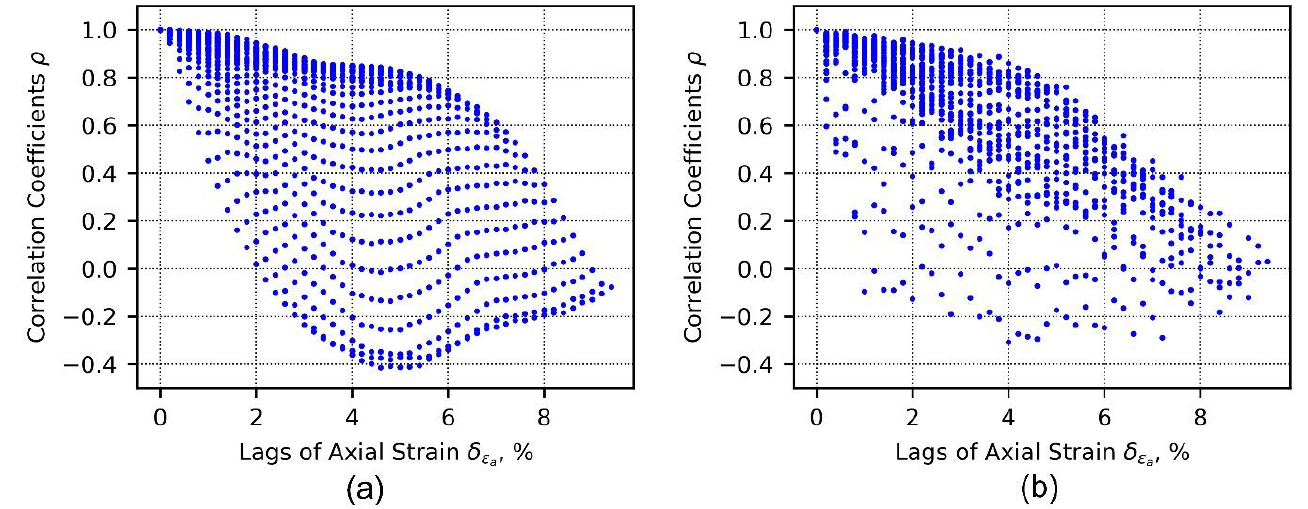
Figure 5. Correlation coefficients computed from axial stress–strain data ensemble ( a ) and axial strain–volumetric strain data ensemble ( b ).